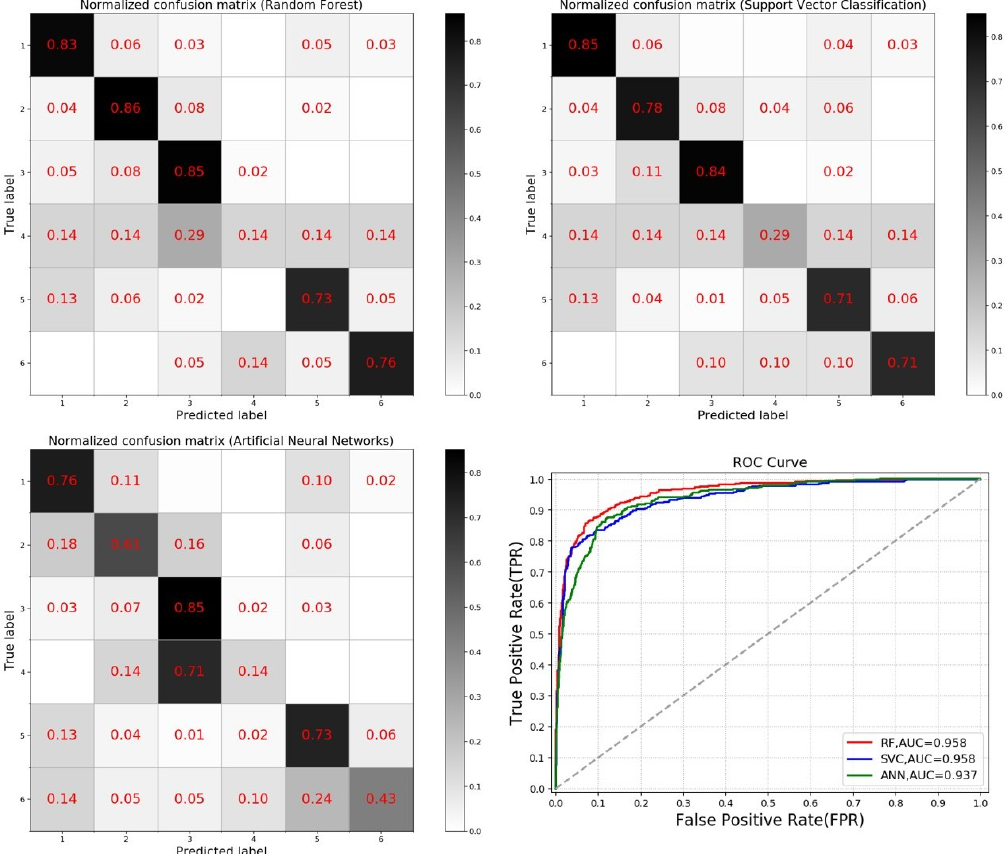
Figure 7. Confusion matrix and Receiver Operating Characteristic (ROC) curve for the Level I land-use classification.